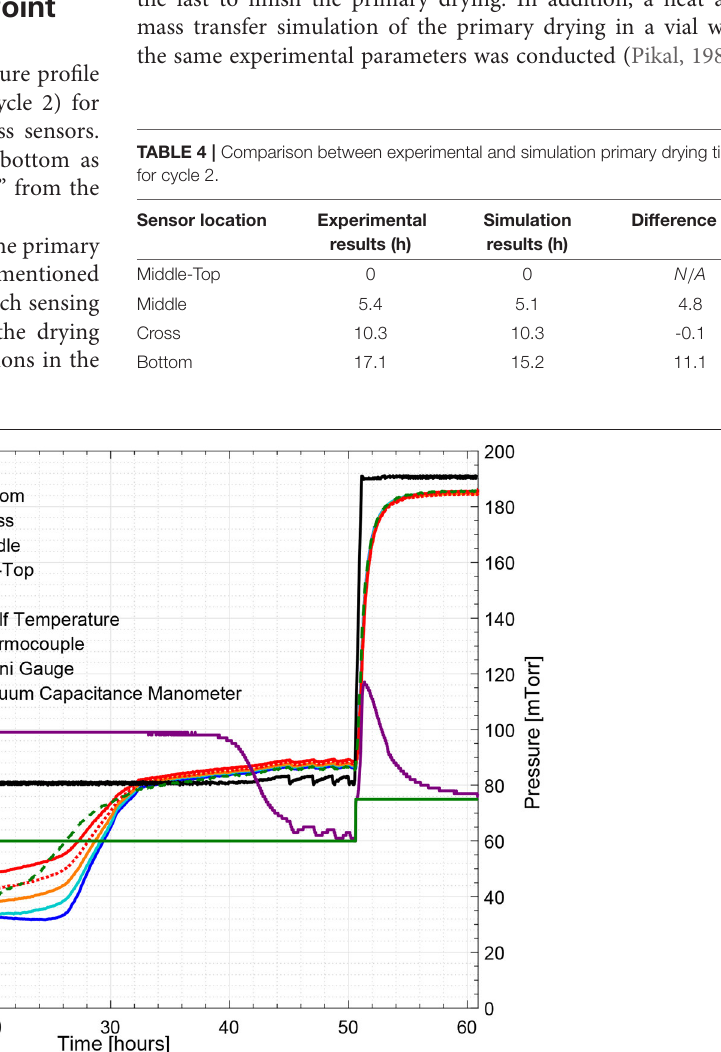
Frontiers in Chemistry |